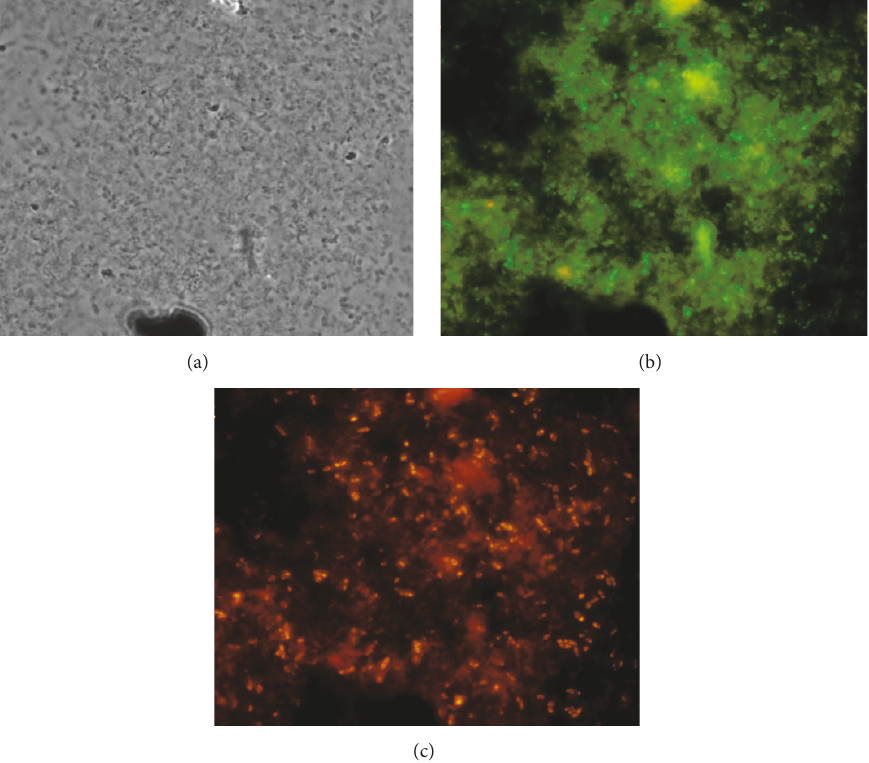
Figure 5: Micrographs (magnification: 1000x) of the flocs under phase contrast and epifluorescence. Comparison of the same floc area. Hybridization target: viable bacteria and Betaproteobacteria. (a) Phase contrast. Identical microscopic fields under fluorescence: (b) detection of all viable bacteria and (c) analysis with a specific probe for